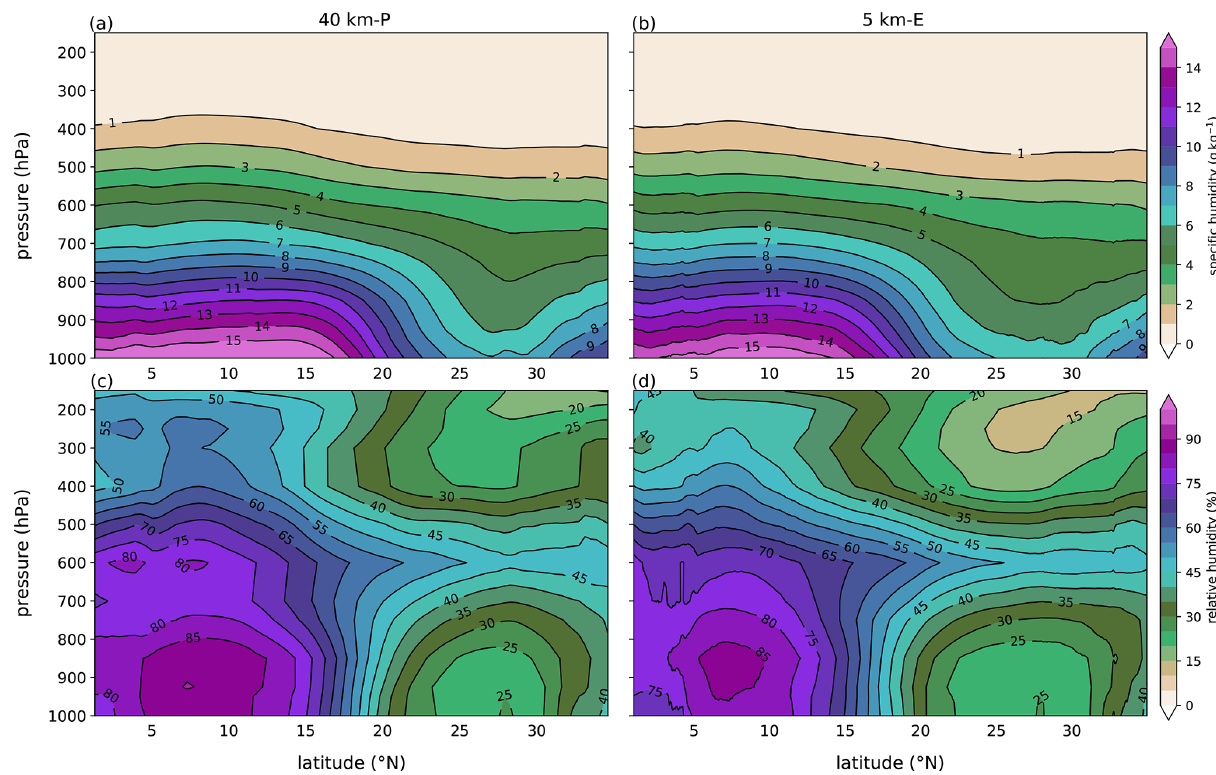
Figure 8. JAS mean vertical cross section of specific humidity in gkg − 1 in the two upper panels (a, b) and for relative humidity in % in the two bottom panels (c, d) for the 40km-P (a, c) and the 5km-E (b, d) simulations, respectively. The mean is taken over land of the “WA domain” (dashed domain) outlined in Fig. 1.